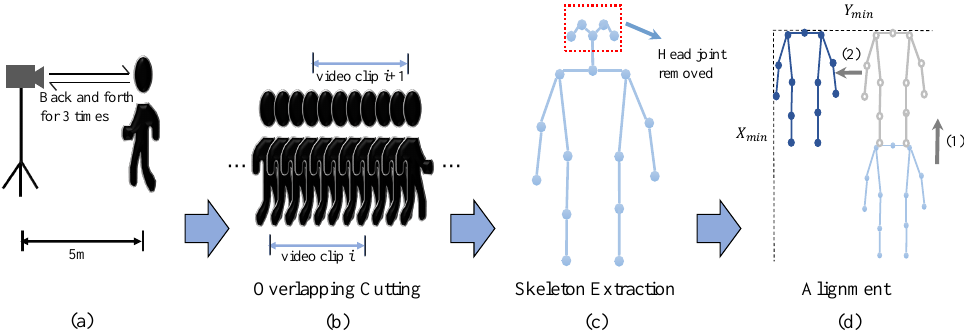
Figure 1. The overall process of data collection and preprocessing. All the videos captured in process ( a ) are then cut into the same length in ( b ). In process of ( c ), HRNet was used to extract human skeletons. ( d ) shows the process of skeleton